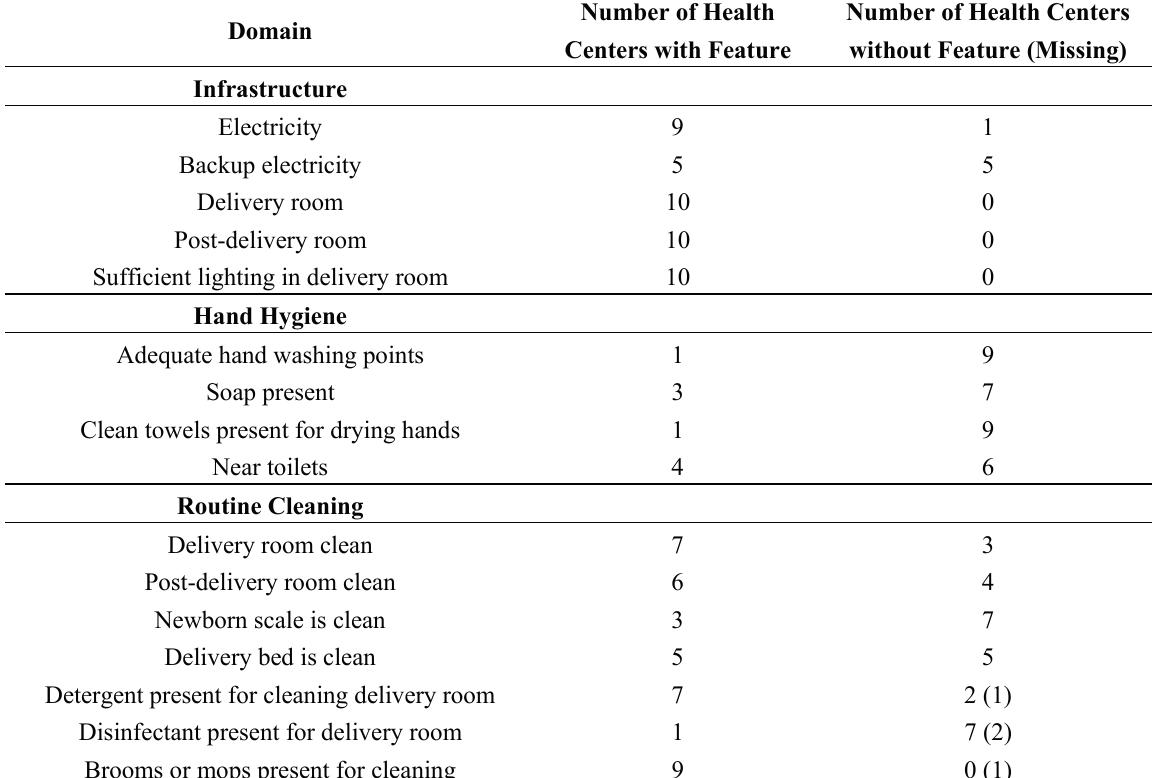
Table 3. Summary scores from health center